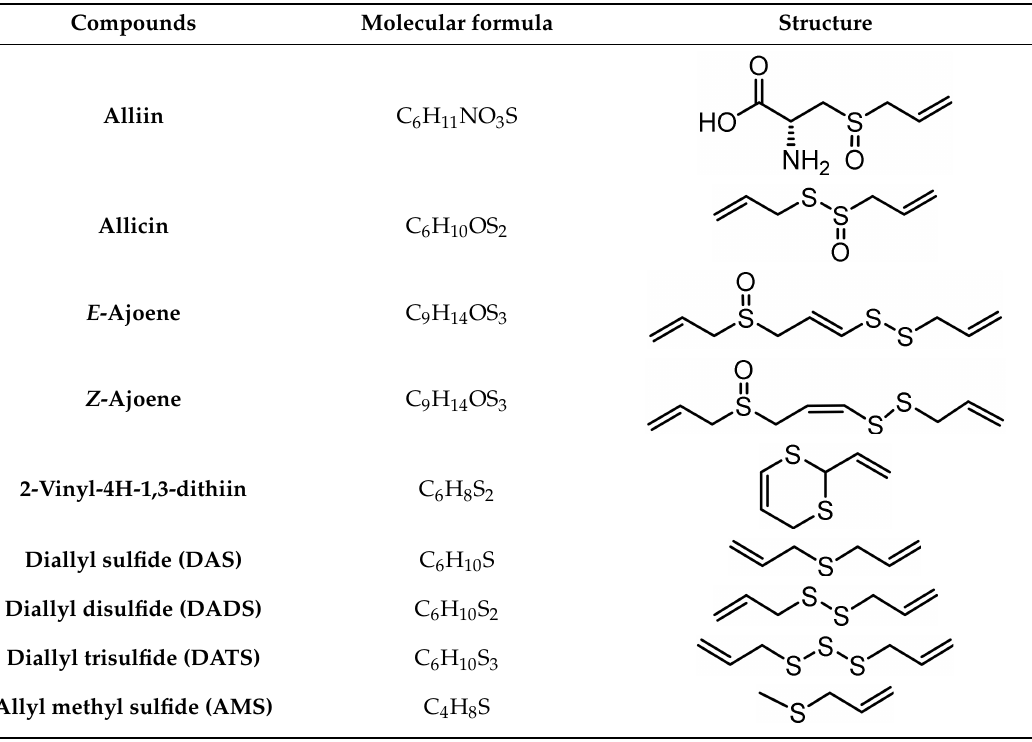
Table 1. List and structures of some of the sulfur-containing compounds isolated from Allium sativum